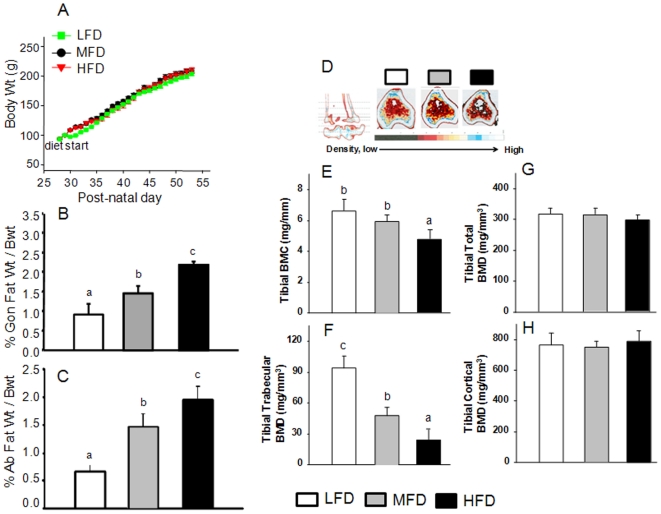
Effect of increasing dietary fat on body weight and composition in male rats.LFD, low fat diet (control pelleted AIN-93G 14% fat diet); MFD, medium fat TEN diet (25% fat diet); HFD, high fat TEN diet (45% fat diet). (A), growth curves from three different diet groups. (B), visceral (gonadal fat) % body weight and (C), abdominal fat % body weight (D), Representative pseudocolored images of tibial peripheral quantitative CT scans (pQCT) (slice 3) from LFD, MFD and HFD rats. Color changes from blue, yellow, red, to gray represent decreases in bone density. Decreased bone mass in male rats fed HFD can be visualized. (E), total tibial bone mineral content (BMC). (F), tibial trabecular bone mineral density (BMD). (G), total tibial BMD. (H), tibial cortical BMD. Data bars are expressed as mean ± SEM (n = 6/group). Means with different letters differ significantly from each other at P<0.05, a<b<c as determined by two-way ANOVA followed by Student-Newman-Keuls post hoc analysis for multiple pairwise comparisons.